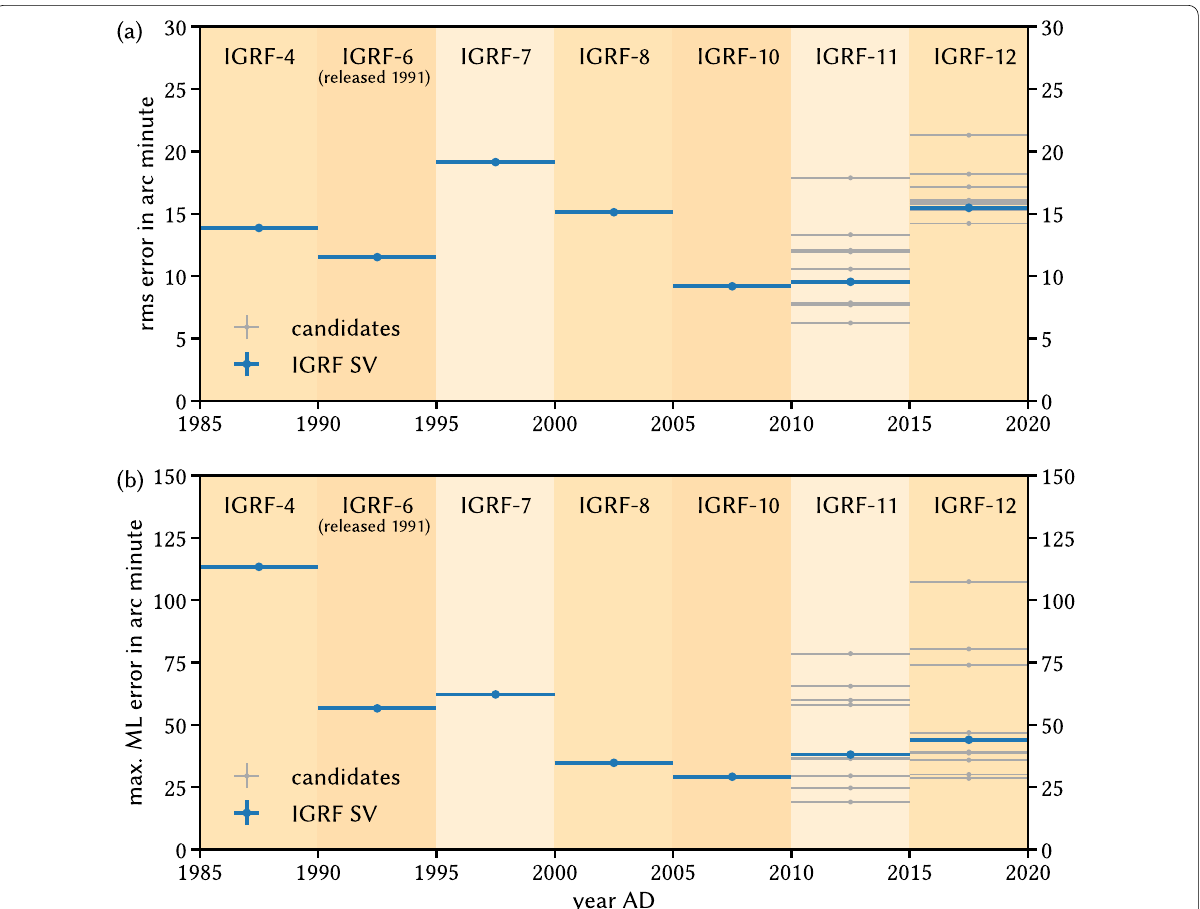
Fig. 6 Direction error at Earth’s surface for past IGRF SV models (blue) and IGRF-11 and IGRF-12 candidate models (in grey). a Root-mean-squared error. b Maximum error at mid-latitude ML (absolute value geographic latitude smaller than 60 ◦ ). See text for the definition of the pointwise error. Magnetic fields are expanded up to spherical harmonic degree and order